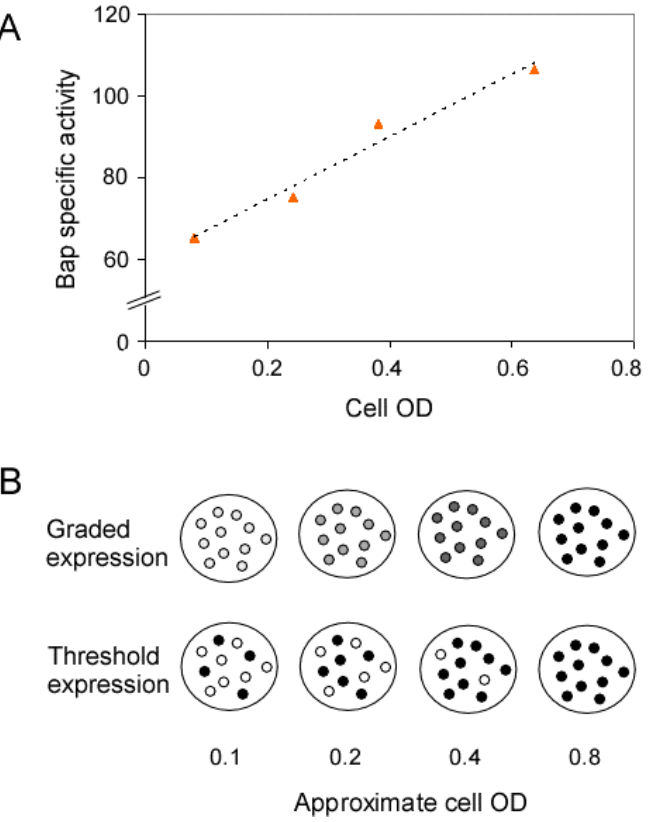
Fig. 2. Time course for PhoB activation by ArcB. (A) E . coli BW31820 (like BW26910, except rhaBp - arcB ∆ arcA ∆ ( ackA pta )) was grown in 1 % glycerol MOPS medium with 1 m M L- rhamnose for 10 hours from a low cell density. The culture was periodically sampled for cell of about 0.1, as density and Bap activity measurements once the density reached an A 410 described in Materials. Bap specific activities (nanomoles product made by minute per cell OD) ) are shown. (B) Graphic representation of graded and threshold and cell optical densities (A 410 expression. See